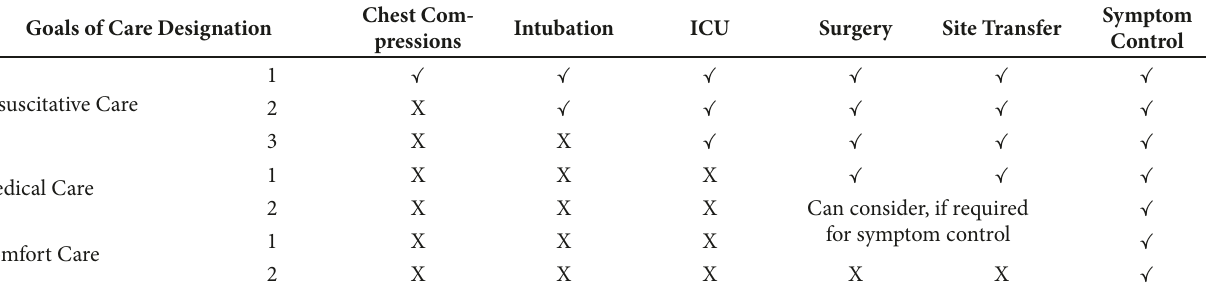
Table 1: Goals of Care Designation